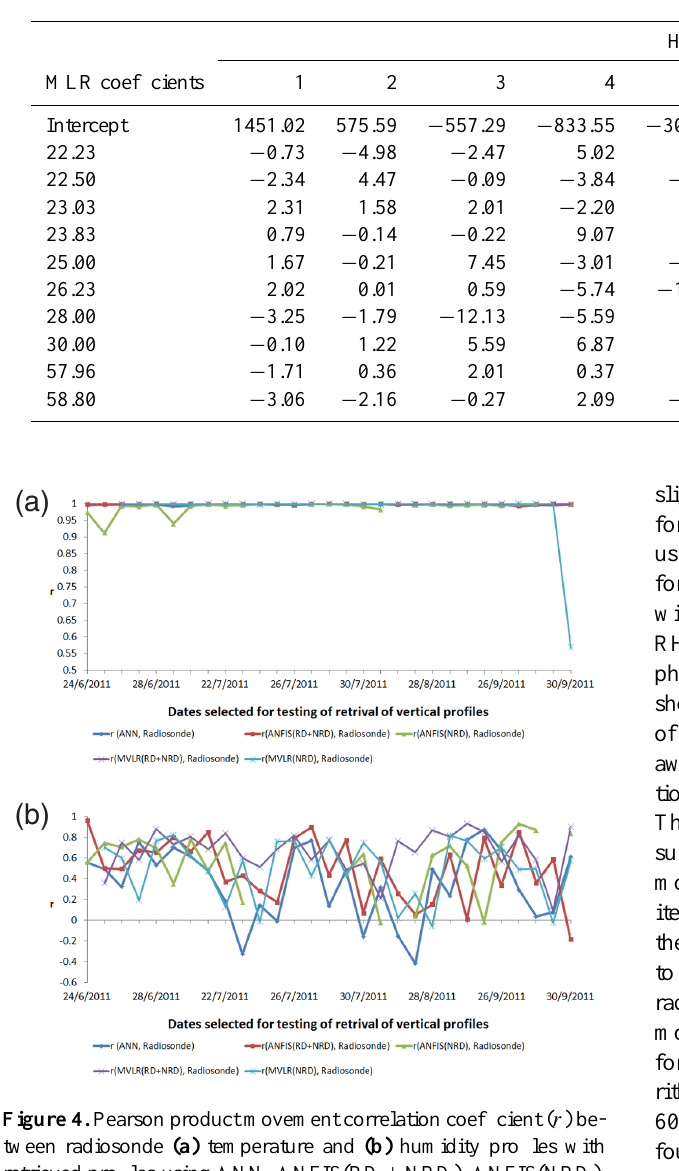
Table 2b. Same as Table 2a but for relative humidity.